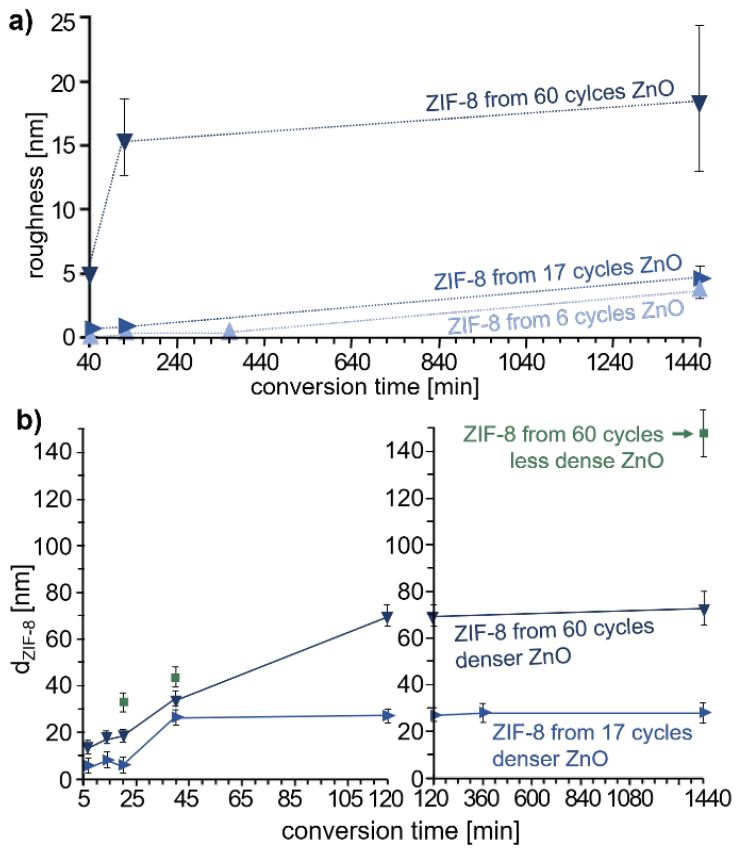
Figure 3. ( a ) RMS roughness of ZIF-8 obtained from ZnO with a density of ρ = (5.2 ± 0.2) g/cm 3 , depending on the employed conversion time; ( b ) Thickness of ZIF-8 (d ZIF-8 ) depending on conversion time measured via spectroscopic ellipsometry. Measured for ZIF-8 obtained from ZnO with densities of ρ = (4.6 ± 0.1) g/cm 3 and of ρ = (5.2 ± 0.2) g/cm 3